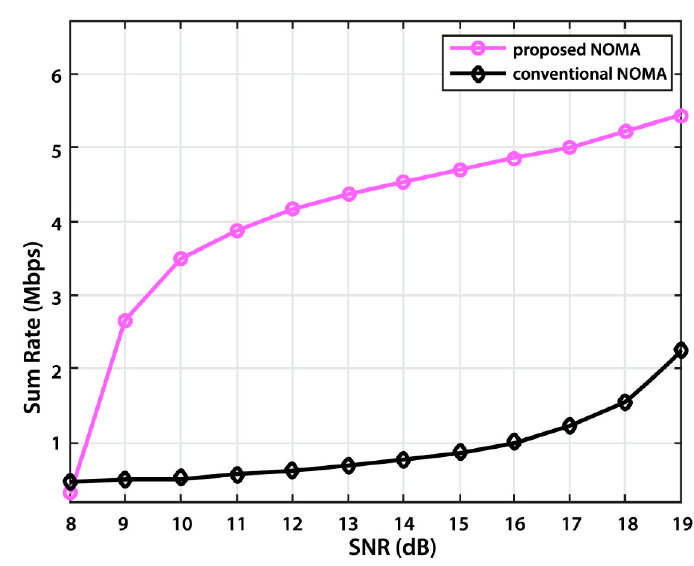
Figure 12. Sum rates for two UEs for the proposed NOMA system versus the conventional NOMA system.